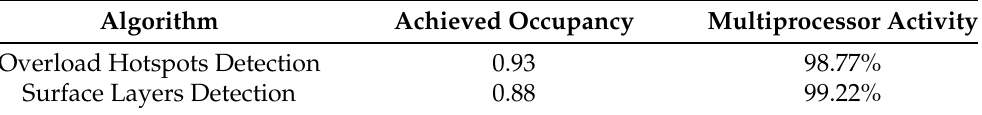
Table 3. Profiled GPU metrics for the implemented